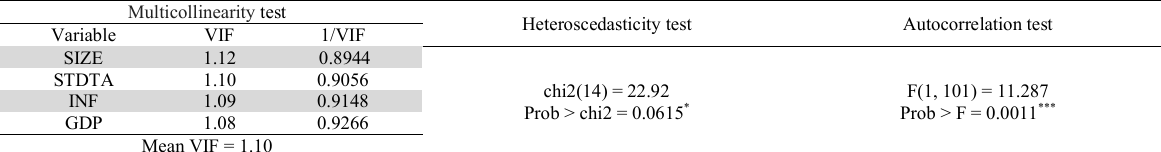
Results of VIF, heteroscedasticity and autocorrelation tests (Model 3) Multicollinearity test